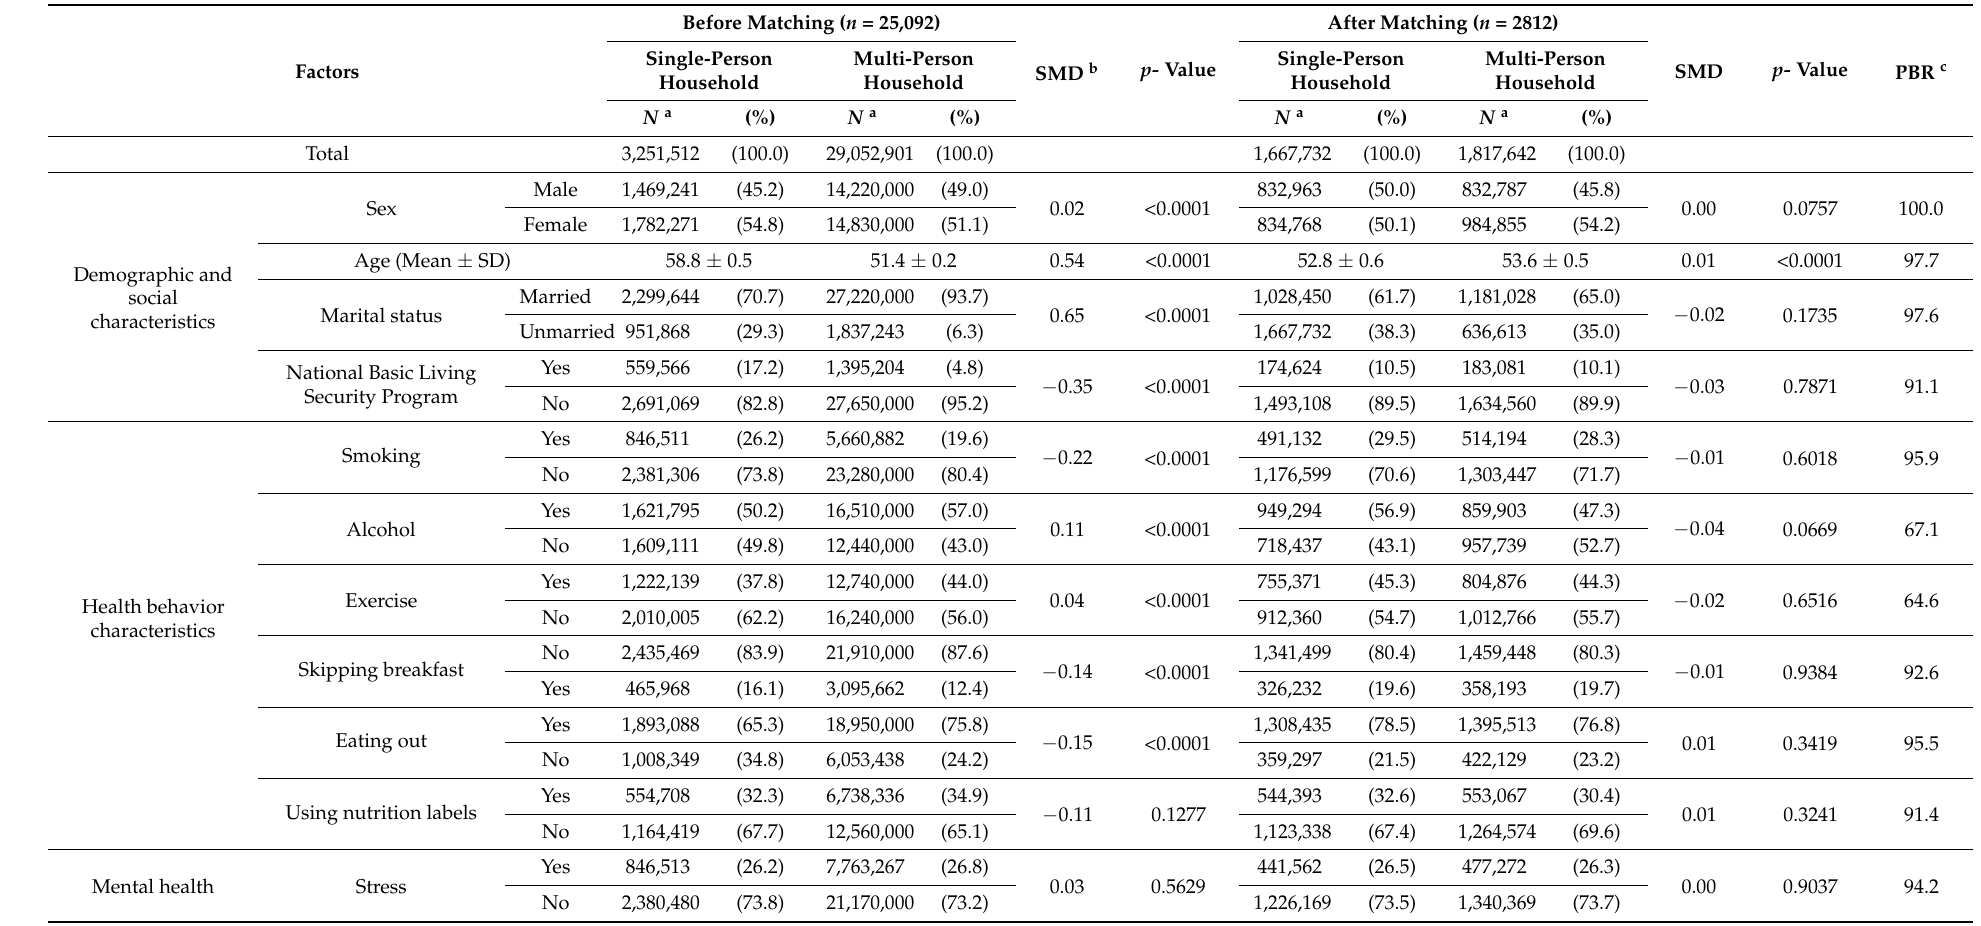
Table 4. Comparison between the unadjusted and adjusted means of covariates on the metabolic syndrome prevalence.